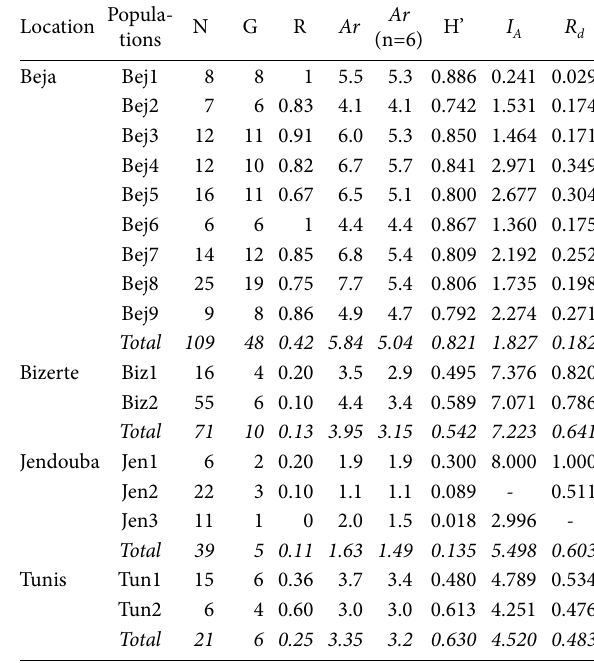
Table 5. Occurrence of multilocus genotypes (MLGs) among six- teen populations of Ascochyta fabae sampled at four locations (Beja, Bizerte, Jendouba, Tunis) in Tunisia, during the 2012 cropping sea- son.